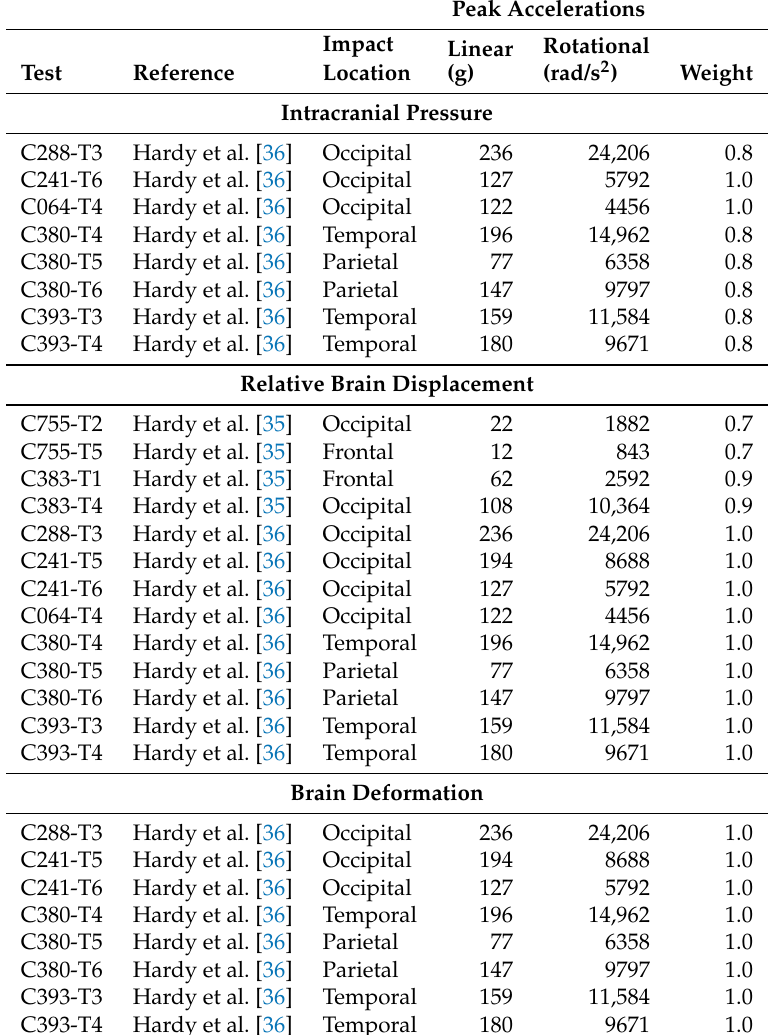
Table 6. Experimental cases passing the selection criteria proposed by Giordano and Kleiven [105] during critical evaluation of the empirical data from Nahum et al. [34], Hardy et al. [35], Trosseille et al. [38] and Hardy et al. [36] for validation against ICP, relative brain displacement and brain deformation. Each impact is summarised by its location, the peak resultant linear acceleration and the peak rotational acceleration about a single axis. Where impact cases have been selected for multiple validation criteria, repeats have been indicated through